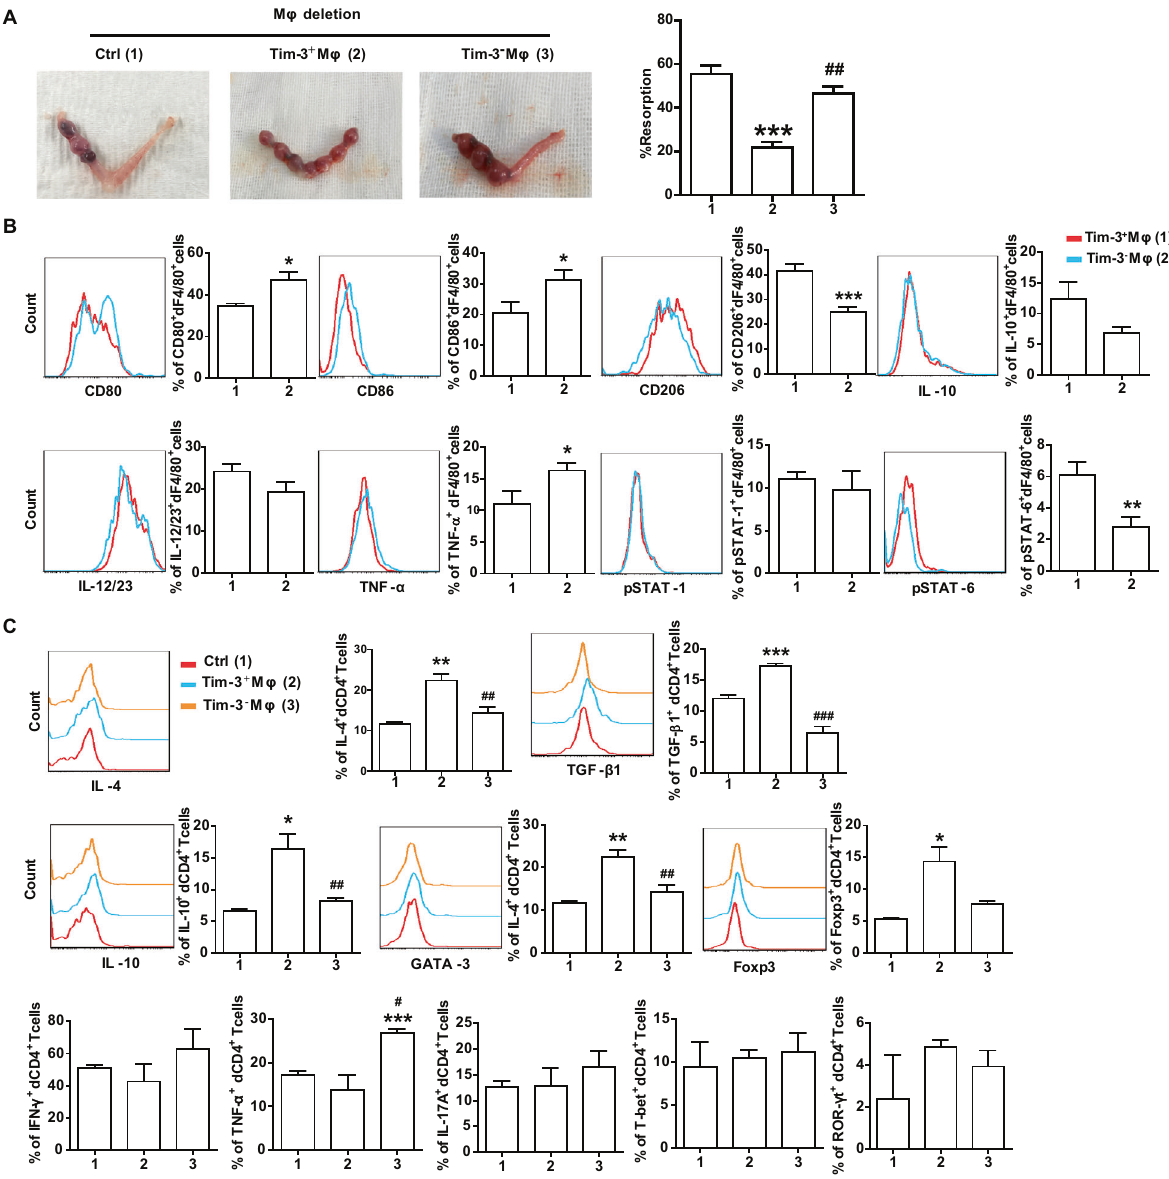
Fig. 4 Adoptive transfer of Tim-3 + M φ s relieved murine embryo absorption induced by M φ depletion. A Representative images of uterus and the percent of fetal resorption in pregnant CBA/J mice with M φ depletion or those that received adoptive transfer of Tim-3 + M φ s or Tim- 3 − M φ s and at GD 4.5. Data represent the mean ± SEM of n = 4 mice per group and are representative of three independent analyses. *** p < 0.001, compared with the control group. ## p < 0.01, compared with the group of Tim-3 + M φ s. B Flow cytometric analysis and quanti fi cation of frequency of surface molecule, cytokine and transcription factor expression by dF4/80 + cells from pregnant CBA/J females with M φ depletion after adoptive transfer of Tim-3 + M φ s or Tim-3 − M φ s. Data represent the mean ± SEM of n = 6 – 9 mice per group. * p < 0.05, ** p < 0.01, compared with the Tim-3 + M φ s group. C Quanti fi cation of fl ow cytometric analysis of cytokine production and transcription factor expression by dCD4 + T cells from pregnant CBA/J females with M φ depletion or those that received adoptive transfer of Tim-3 + M φ s or Tim-3 − M φ s. Data represent the mean ± SEM of n = 3 – 6 mice per group. * p < 0.05, ** p < 0.01, *** p < 0.001, compared with the control group. # p < 0.5, ## p < 0.01, ### p < 0.001, compared with the group of Tim-3 + M φ s.